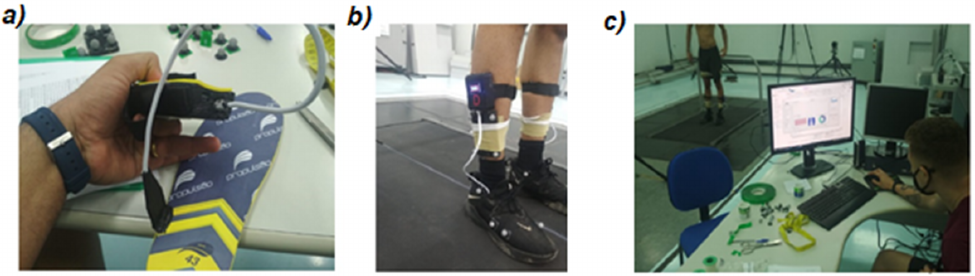
Figure A2. ( a ) Sensorized insole system for research (bigger battery). ( b ) Preparation of the partici- pants for data acquisition with the joint use of the sensorized insole and the treadmill force plate TFP. ( c ) Data collection in a motion analysis laboratory.